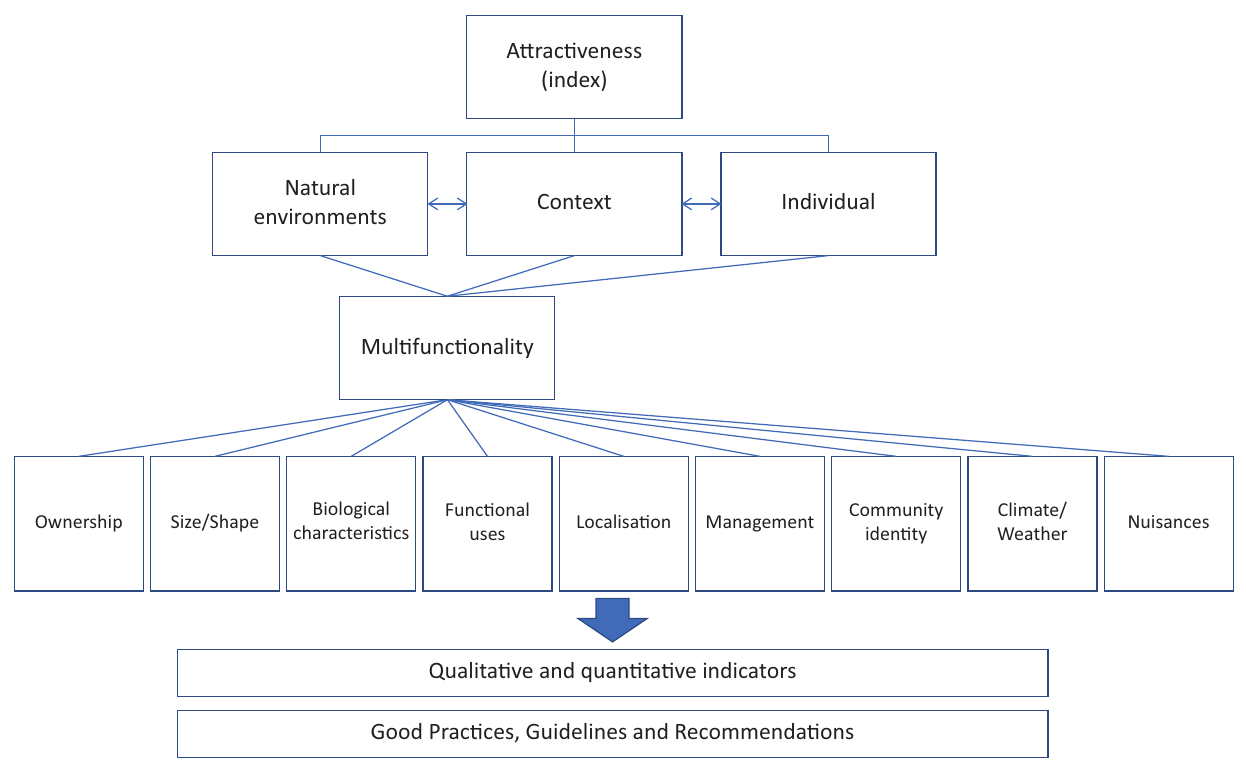
Figure 3. Nine core characteristics that contribute to the attractiveness of public green spaces are shown as ownership, size/shape, biological characteristics, functional uses, localisation, management, community identity, climate/weather, and